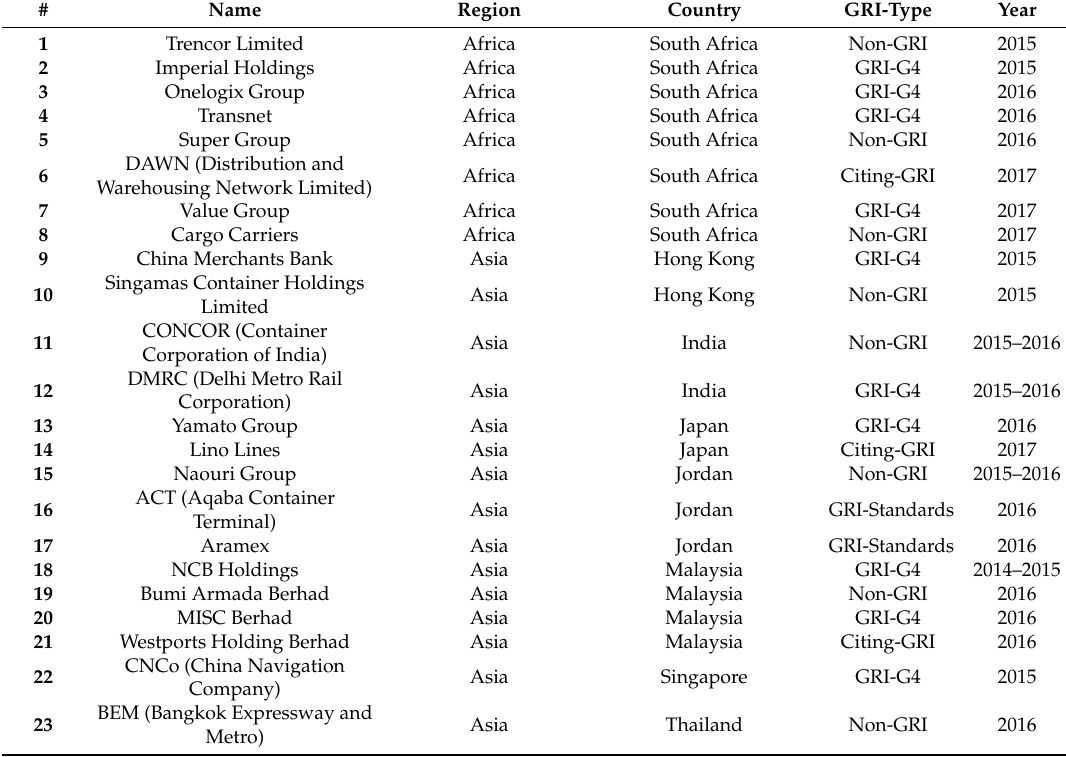
Table A2. Overview of logistics companies analyzed in this